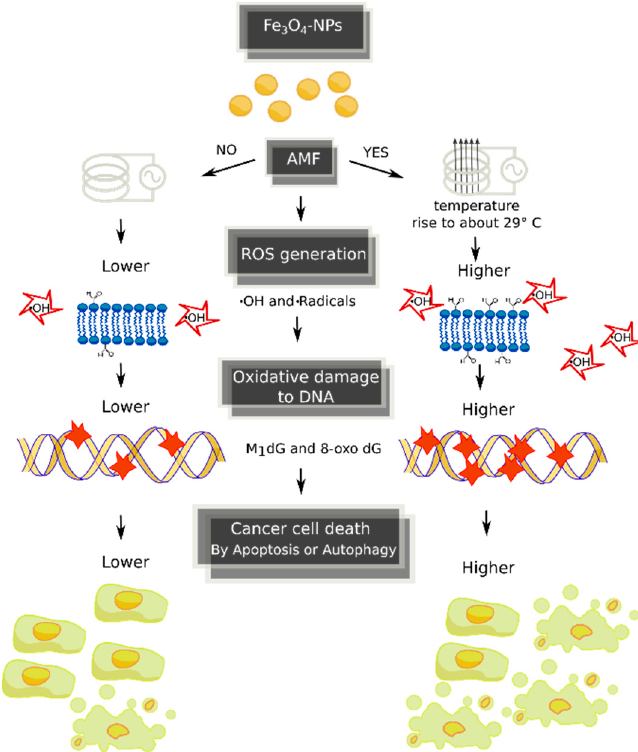
Figure 3. Potential mechanisms underlying the genotoxic effects caused by magnetic hyperthermia. AMF, alternating magnetic field; ROS, reactive oxygen species.